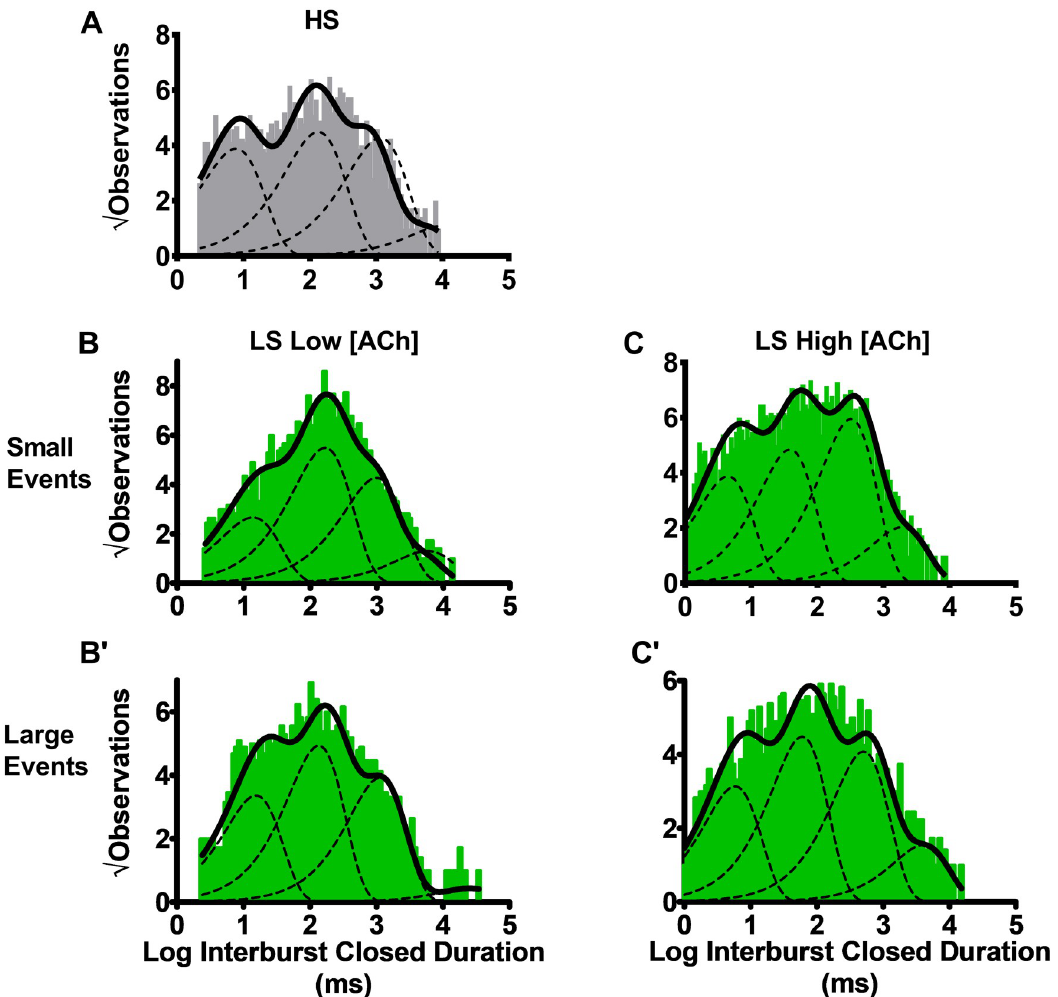
Fig 6. Closed durations between burst activity of human HS or LS α 4 β 2-nAChR isoforms. Closed dwell durations between bursts of activity (interburst durations) were measured for HS or LS α 4 β 2-nAChR isoforms expressed in X . laevis oocytes using unlinked subunits. (A) For HS ( α 4 β 2) 2 β 2-nAChR, interburst closed durations evoked by 1.3 μ M ACh were best described using four time constants. The same was true for closed durations between bursts of either small (B) or large amplitude (B’) events evoked from LS ( α 4 β 2) 2 α 4-nAChR at a low ACh concentration (0.7 μ M). Increasing the ACh concentration to 30 μ M did not change the number of time constants associated with LS ( α 4 β 2) 2 α 4-nAChR closed state intervals between bursts of small (C) or large (C’) events, but did result in significant shortening of the time constants in each case. Closed and open dwell duration pooled histograms are shown, which result from collection of data from 6–7 individual patches, across at least three separate experiments. The calculated τ values are summarized in Table 3, together with the statistical analyses